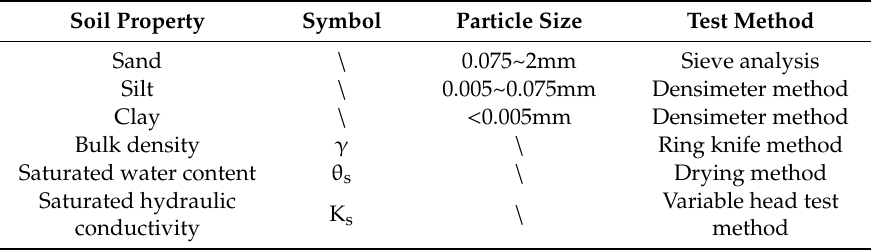
Table 1. Test methods of soil properties.